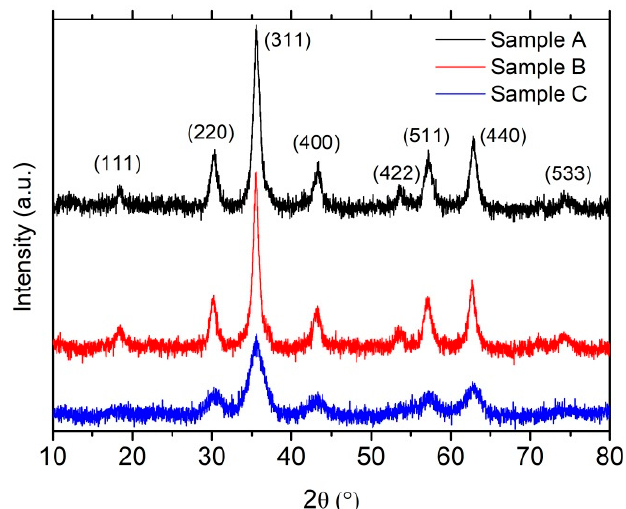
Figure 1. Diffractograms measured for sample A (bare Fe 3 O 4 NPs), sample B (citrate-coated NPs, ex situ) and sample C (citrate-coated NPs, in situ). The curves are offset to improve the clarity of the plot. The main peaks in the diffractograms are indexed on the basis of the structure of